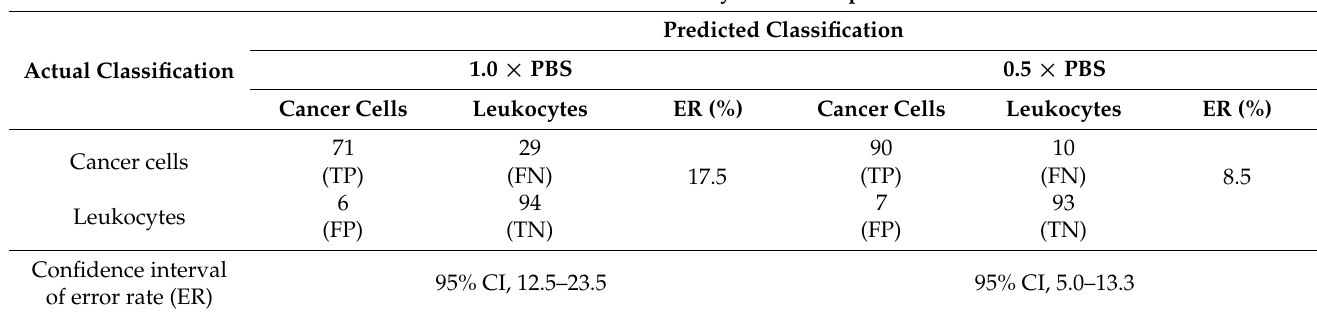
Confidence interval of error rate